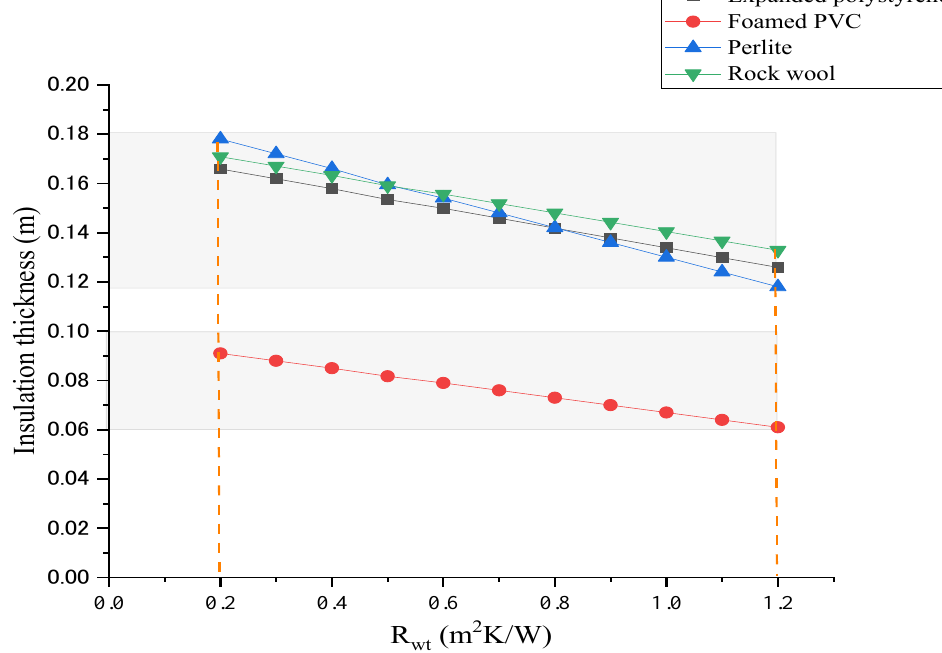
Figure 7. The effect of R wt on the optimum thickness of insulating materials.